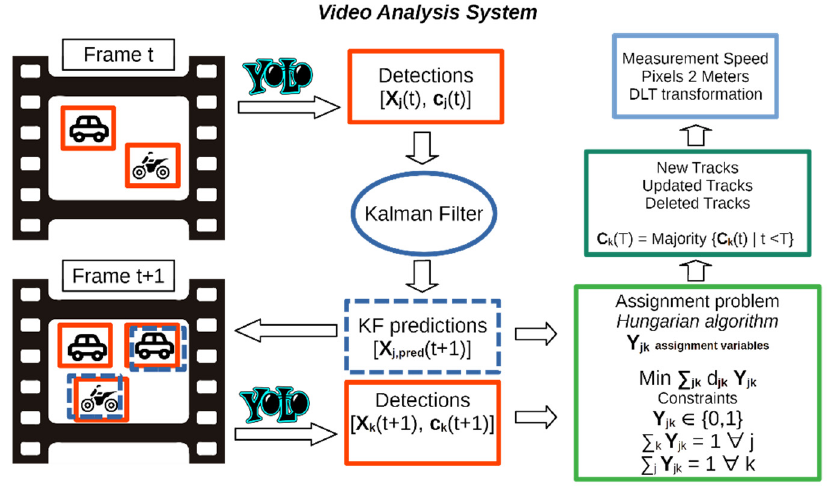
Figure 3. Video analysis system schematic drawing.